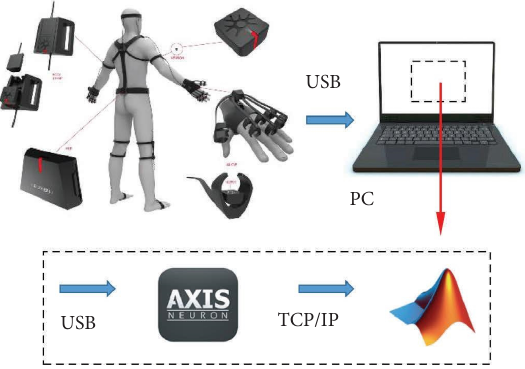
Figure 8: Schematic diagram of the human data collection.